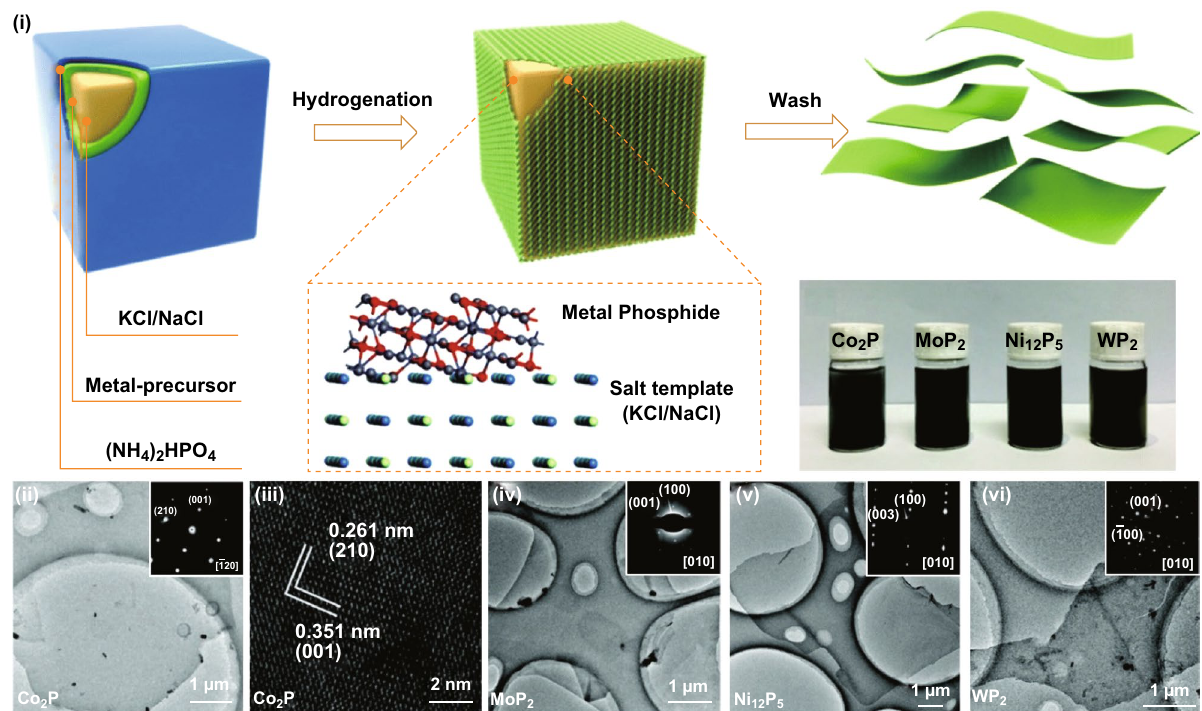
Fig. 13 Large-area synthesis of 2D metal phosphides. ( i ) Schematic representation of the synthesis process and optical images of 2D metal phosphides. ( ii ) TEM (inset: the corresponding SAED pattern) and ( iii ) HRTEM images of 2D Co 2 P. TEM images (inset: the corresponding SAED pattern) of 2D MoP 2 ( iv ), Ni 12 P 5 ( v ) and WP 2 ( vi ). Adapted with permission from Ref. [122]. Copyright 2018, The Royal Society of Chemistry Publishing